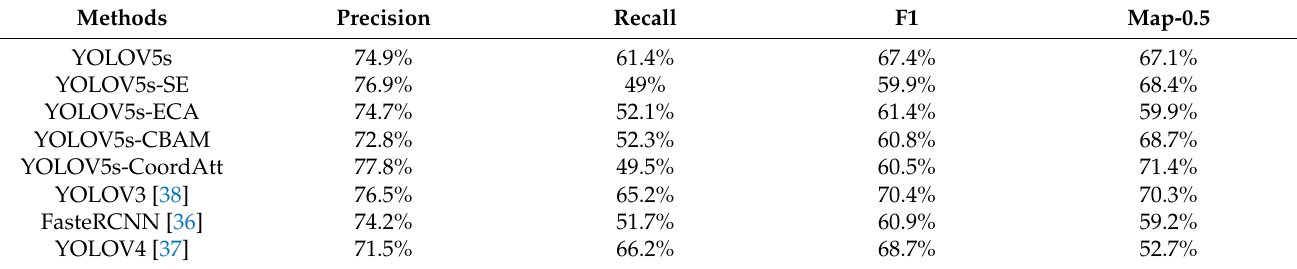
Table 6. The evaluation results of various pavement crack detection methods (public datasets).